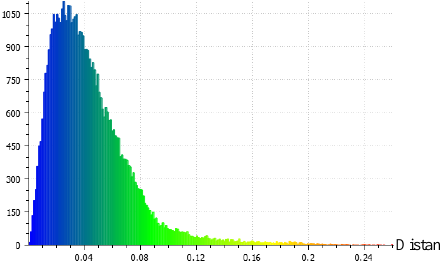
Figure 13. Point-to-point distance histogram before pyramid registration.